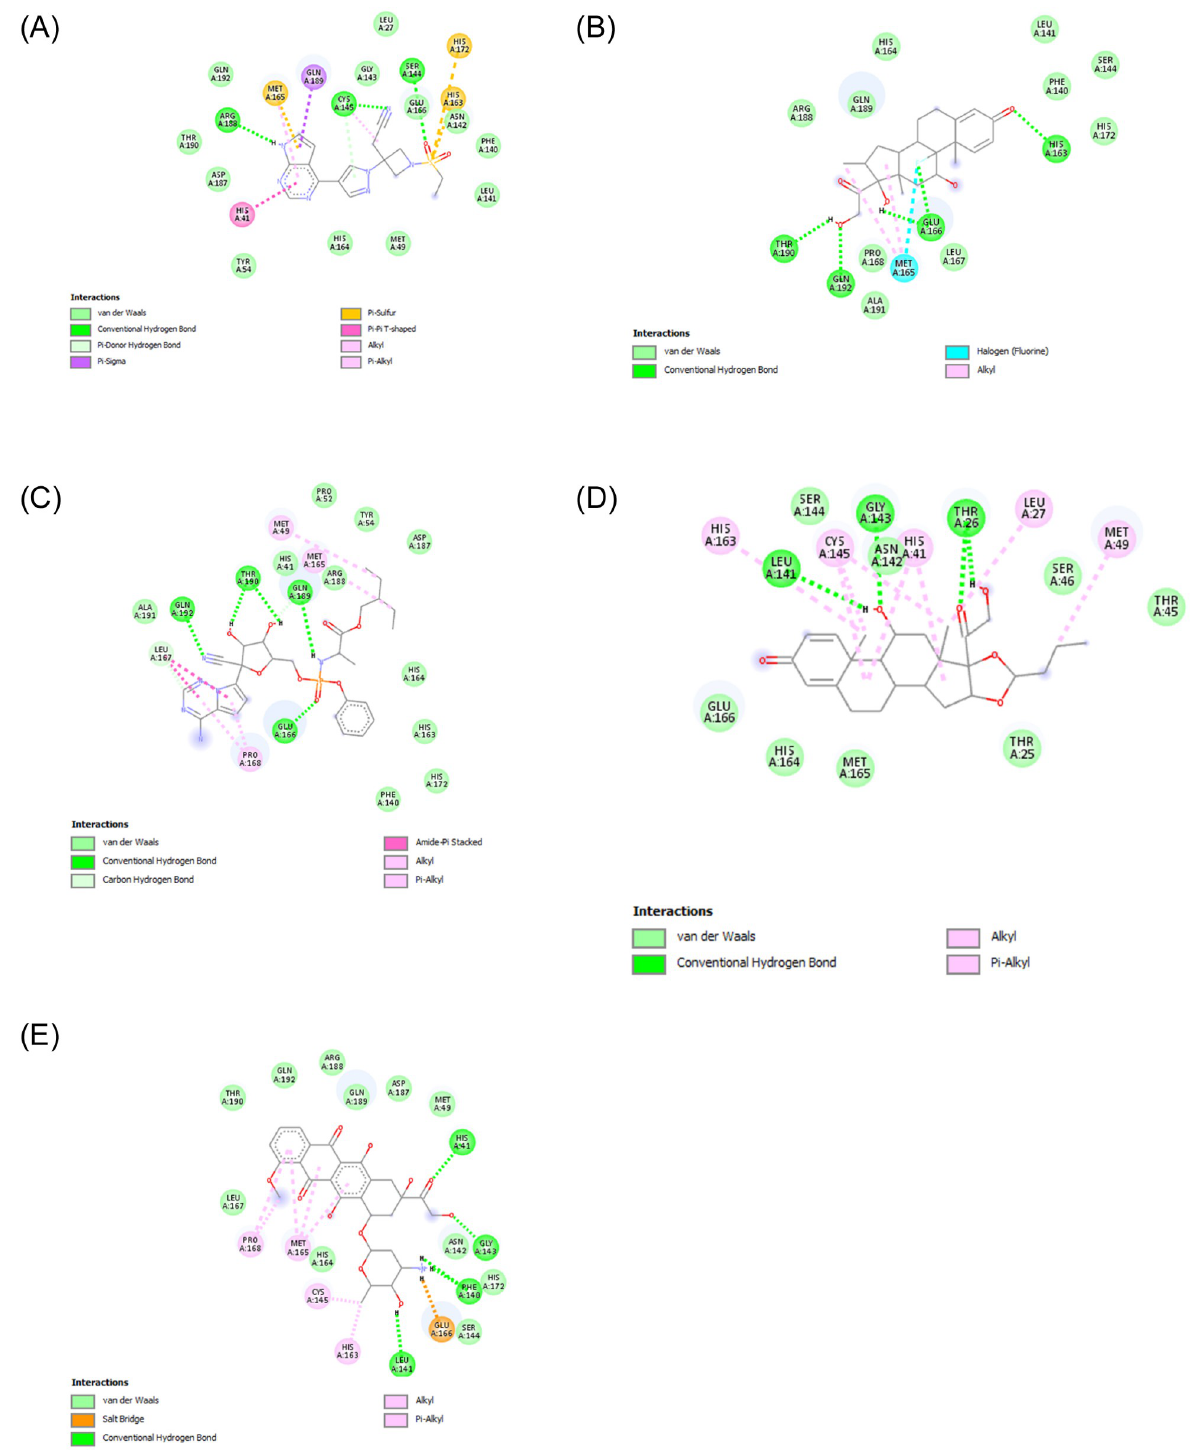
Fig 7. 2D interactions of candidate drugs with target protein. A . 2D bond-graph of baricitinib binding with target. B . 2D bond-graph of dexamethasone binding with target. C . 2D bond-graph of remdesivir binding with target. D . 2D bond-graph of budesonide binding with target. E . 2D bond-graph of doxyrubicin binding with